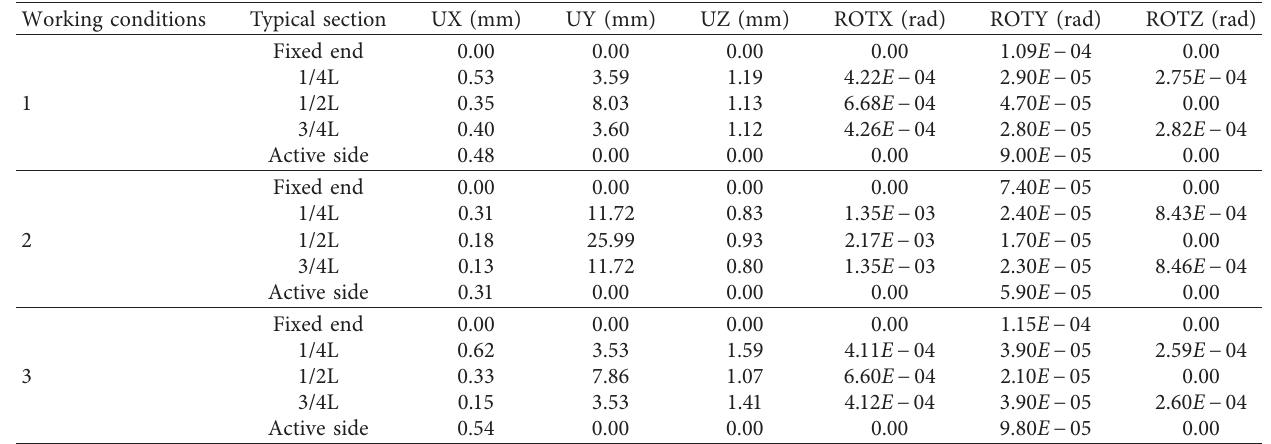
Table 7: The peak values of displacement of the